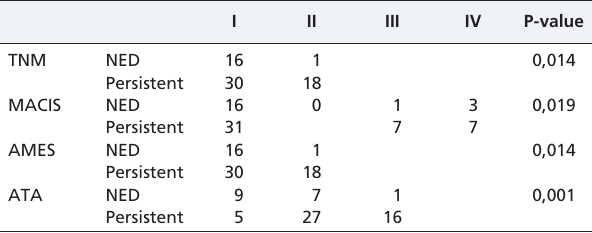
Table 1 - Initial presentation and good response to initial therapy with I-131-Therapy.